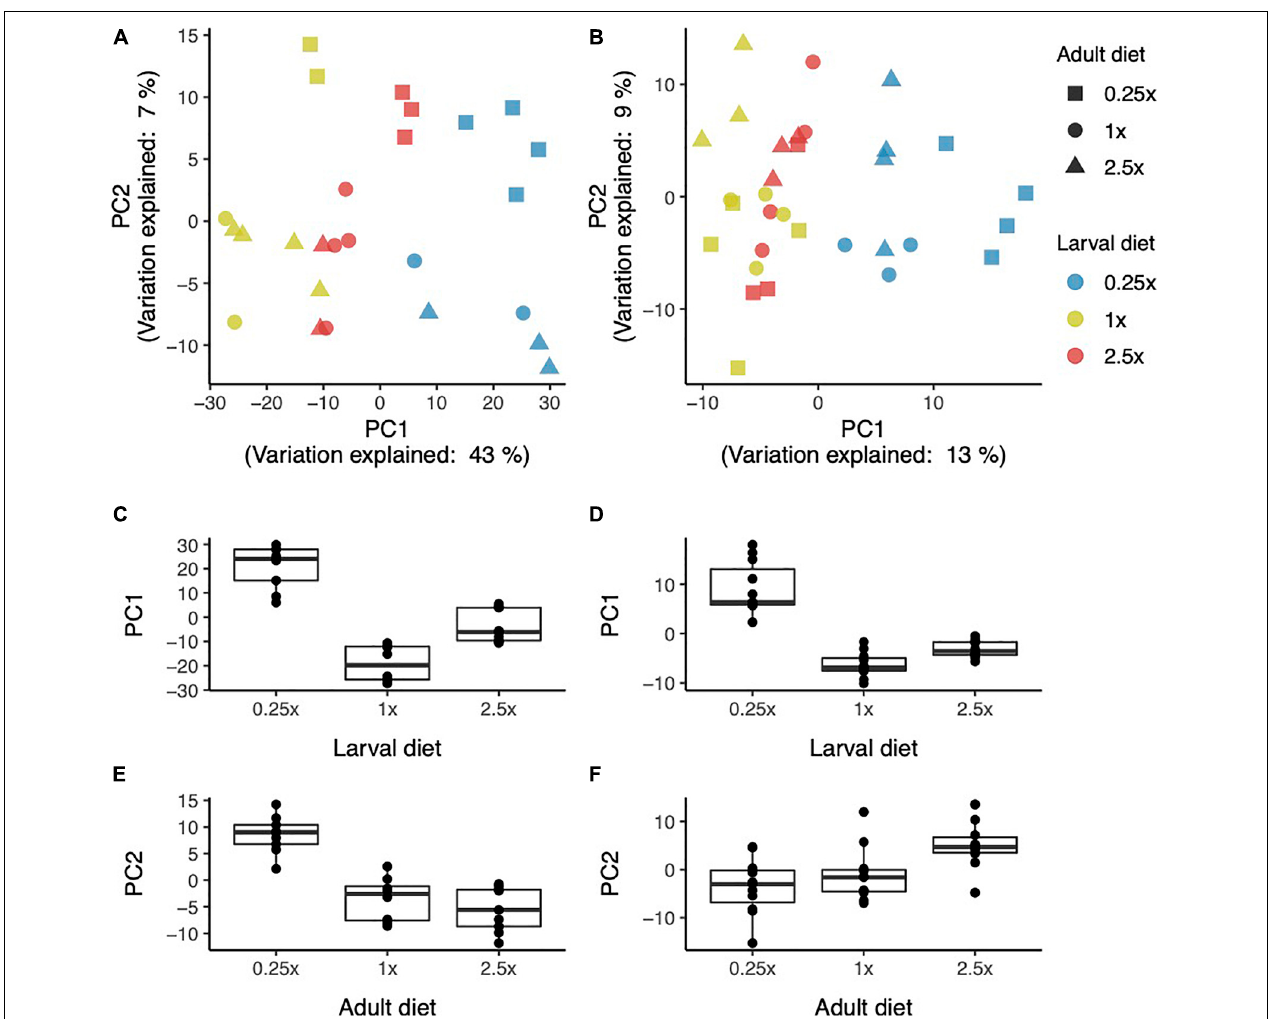
FIGURE 1 | Principle component analysis of global gene expression. PC1 vs. PC2 in females (A) and males (B) . Larval diet vs. PC1 in females (C) and males (D) and adult diet vs. PC2 in females (E) and males (F)